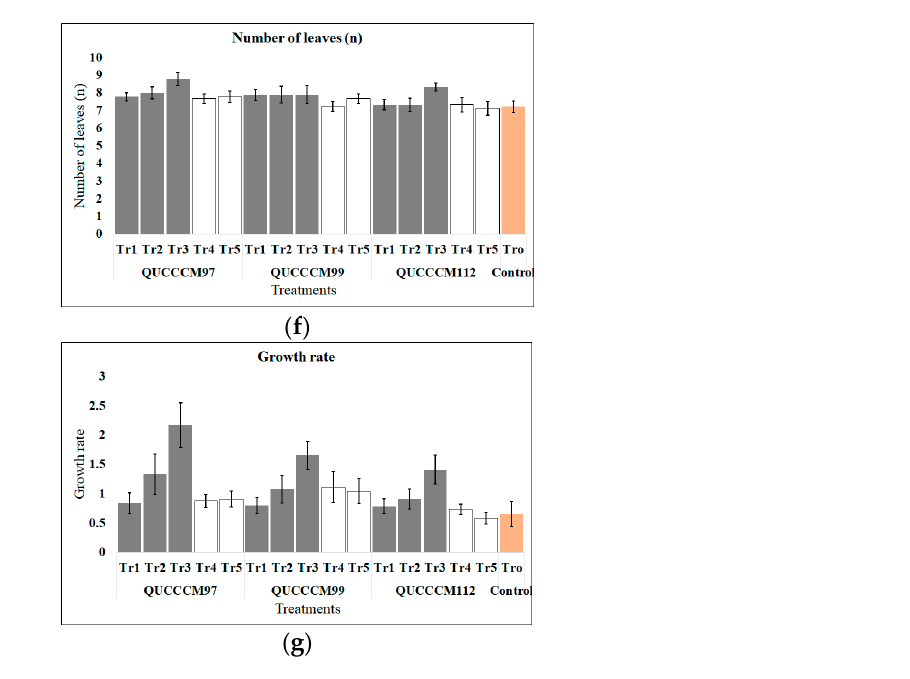
Figure 5. ( a – g ) Shoot length, root length, fresh weight, dry weight, spad index, number of leaves, and growth rate of bell pepper untreated seedlings (Tr 0 ), treated with 0.2% or 2 mL L − 1 (Tr 1 ), 0.4% or 4 mL L − 1 (Tr 2 ), and 0.6% or 6 mL L − 1 (Tr 3 ) of the three microalgae extracts. Additionally, with 0.1% or 1 mg L − 1 (Tr 4 ) and 0.2% or 2 mg L − 1 (Tr 5 ) of the three microalgae